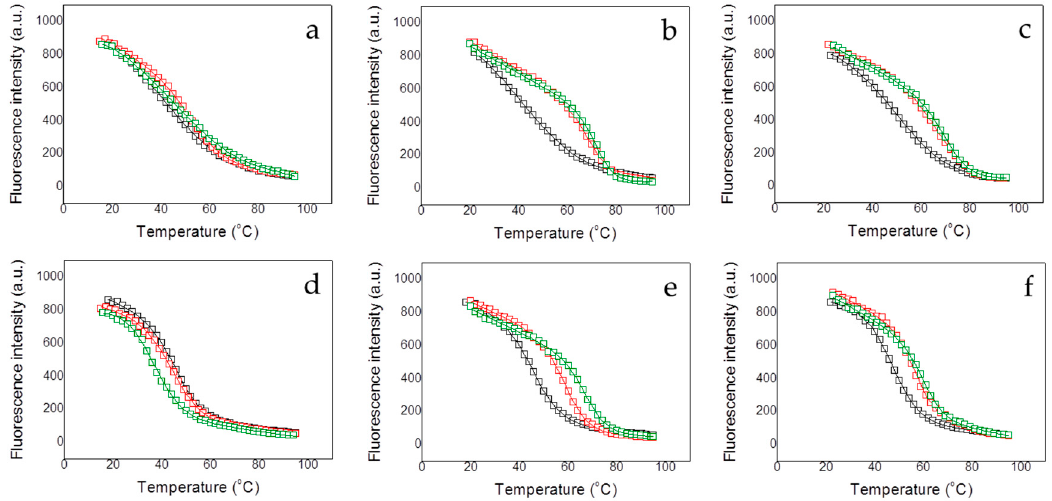
Figure 3. Fluorescence thermal denaturations for the NTD-MBD-ID R106W ( a – c ), and NTD-MBD-ID R133C ( d – f ) under di ff erent conditions. The influence of the pH was assessed (pH 7, black squares; pH 8, red squares; and pH 9, green squares) ( a , d ). The influence of the presence of dsDNA at pH 7 was assessed (absence of dsDNA, black squares; presence of unmethylated CpG-dsDNA, red squares; and presence of methylated mCpG-dsDNA, green squares) at pH 7 and low ionic strength ( b , e ) and high ionic strength ( c , f ). All unfolding traces could be fitted employing a two-state unfolding model (continuous lines) according to Equation 1. Table 1. Thermal stability of the different MeCP2 variants under different conditions.